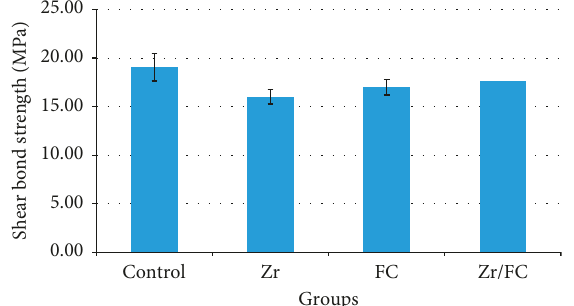
Figure 6: The mean shear bond strengths (MPa) in the four ex- perimental groups. Control: specimens with no surface treatment, Zr: plasma exposure on zirconia, FC: plasma exposure on feld- spathic ceramic, Zr/FC: plasma exposure on both zirconia and feldspathic